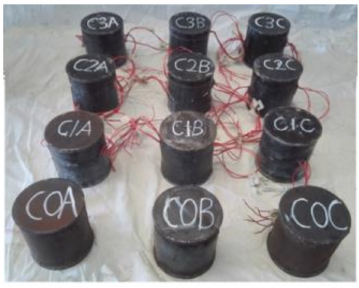
Figure 2. Fabricated CF-CFRP-ST specimens.